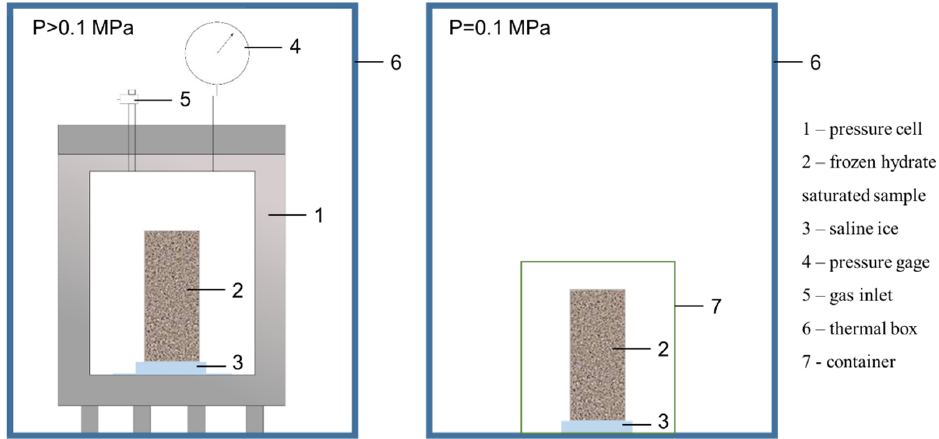
Figure 1. System for modeling the interaction between frozen hydrate-saturated and hydrate-free rocks with saline solutions under atmospheric and higher pressures. The sandy samples were ~80% composed of 0.10–0.25 mm quartz particles (Table 1) and had natural salinity of ~0.01% (Table 2); the active surface area was ~0.6 g/m 2 .